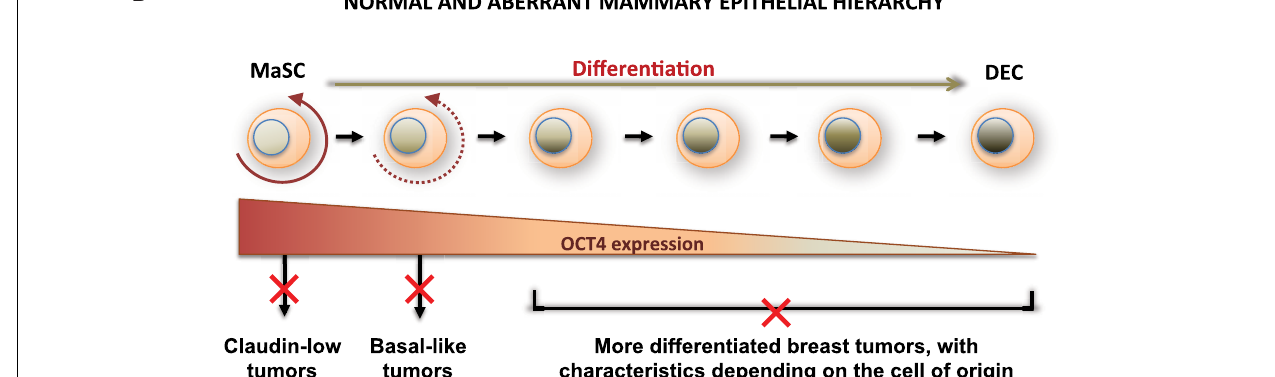
FIGURE 9 | Proposed model of mammary cellular hierarchy integrating expression of OCT4 and its associated embryonic stem cell gene network in the regulation of self-renewal, differentiation, and transformation in the breast. (A) The resting breast is characterized by minimal expression of the ESCTF circuitry, which allows maintenance of quiescence and low self-renewal activity in MaSCs. During pregnancy and lactation and under physiologic cues, OCT4 promoter becomes activated effecting transient activation of other ESCTFs and downstream targets.This regulates a controlled program of MaSC expansion and subsequent